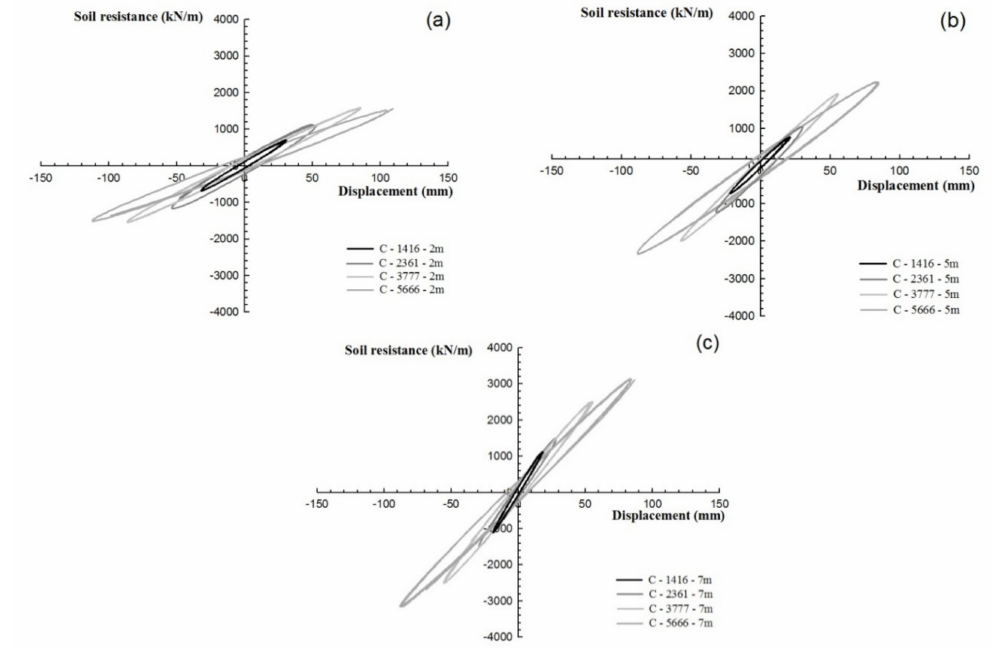
Figure 11. Cyclic p-y curve by load at ( a ) depth = 2 m, ( b ) depth = 5 m, ( c ) depth = 7